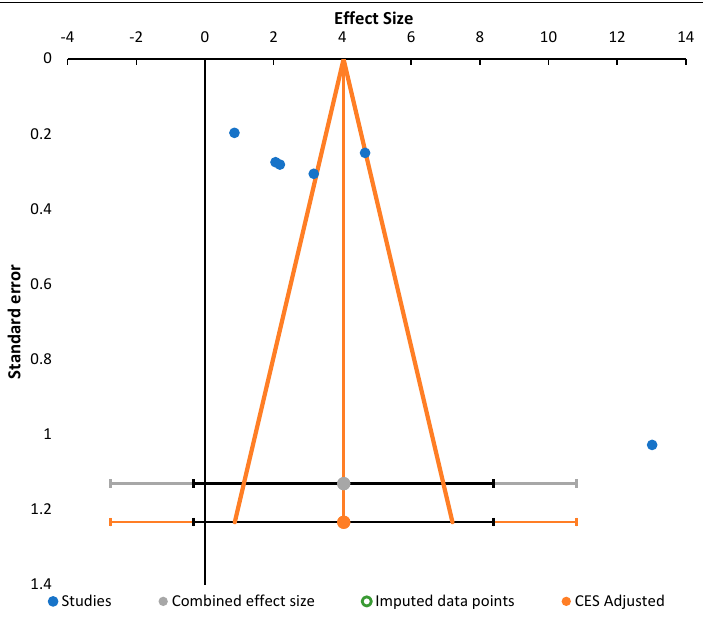
Figure 2. Funnel plot showing random effect meta-analysis of mean difference in decrease of blood glucose level (mg/dL) based on diabetic intervention or negative diabetic